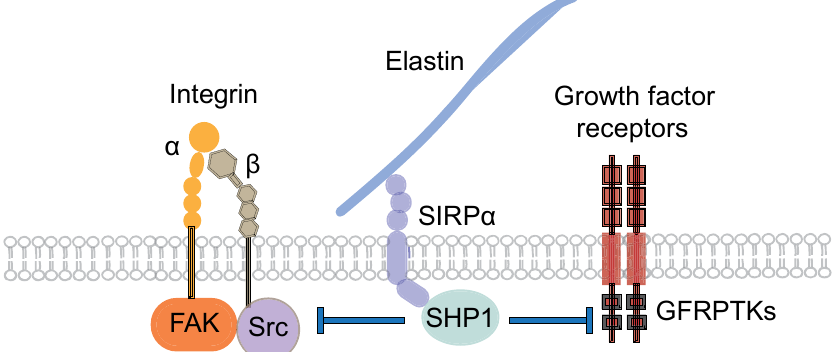
Figure 1. Mechanisms of the inhibitory action of elastin. SIRP α : Signal regulatory protein α . GFRPTK: Growth factor receptor protein tyrosine kinases. FAK: Focal adhesion kinase. Src: Src homology 2 domain-containing protein tyrosine kinase. SHP1: Src homology 2 domain-containing protein tyrosine